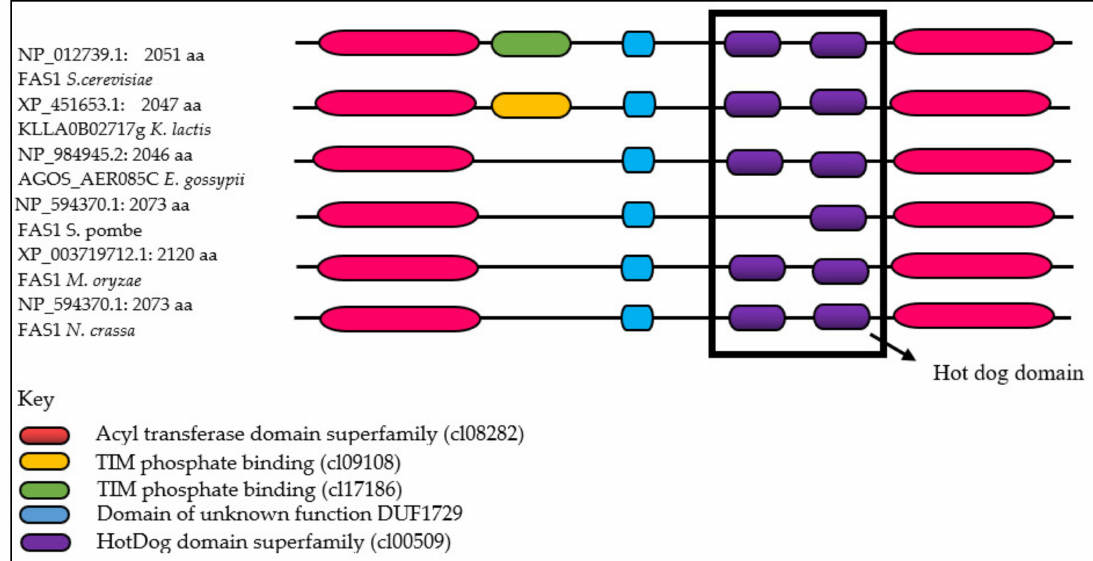
Figure 2. Proteins of Ascomycota identified as putative homologs of Magnaporthe oryzae strain S6 FAS1. The conserved domains and superfamilies of 5 homologous of AscomycotaFAS1 Saccharomyces cerevisiae , uncharacterized protein Kluyveromyces lactis , AER085Cp Eremothecium gossypii , FAS1 Schizosaccharomyces pombe , FAS1 Neurospora crassa and FAS1 Magnaporthe oryzae S6) were analyzed using InterProScan and pfam. Hotdog domain is